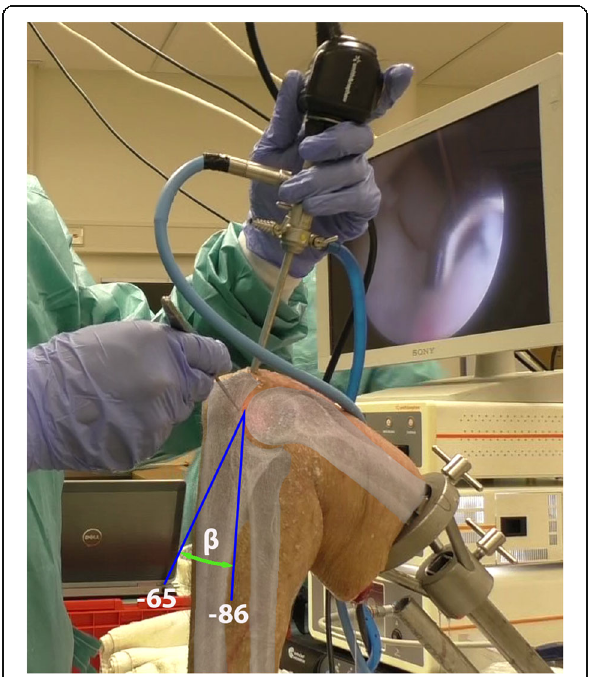
Fig. 5 Median force direction in the vertical plane ( β ) for all compartments combined. Schematic representation of the median direction of Fabs in the vertical plane for all compartments combined represented by β . The blue lines represent the lowest and highest values of the 10th and 90th percentiles of β . An elbow x-ray has been superimposed over the cadaveric elbow to further clarify the correlation between the overall median force direction and elbow